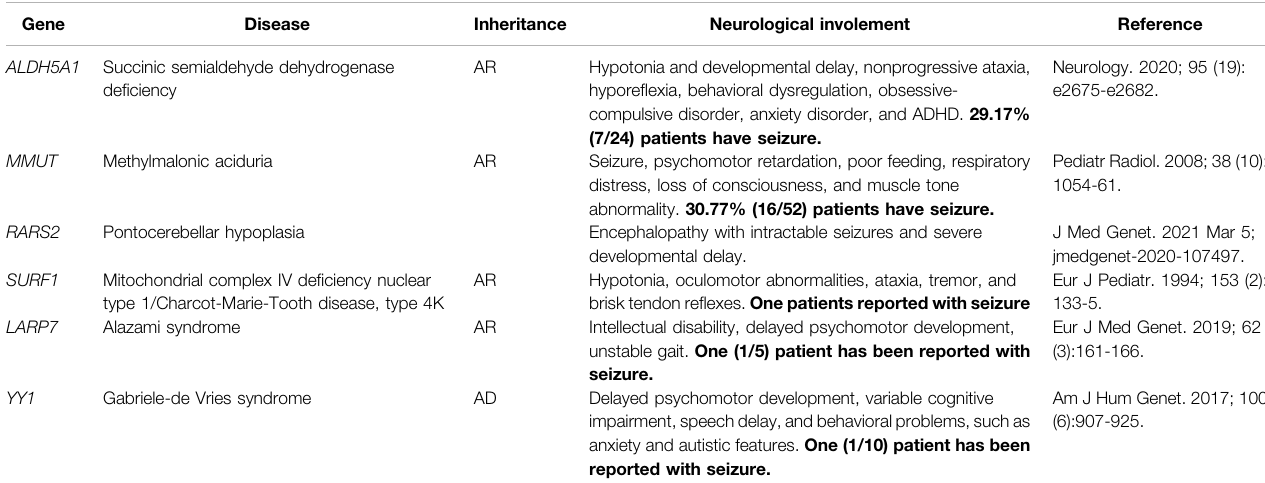
TABLE 2 | Neurological involement information of six genes detected outside the exsiting epilepsy-associated gene list. Gene Disease